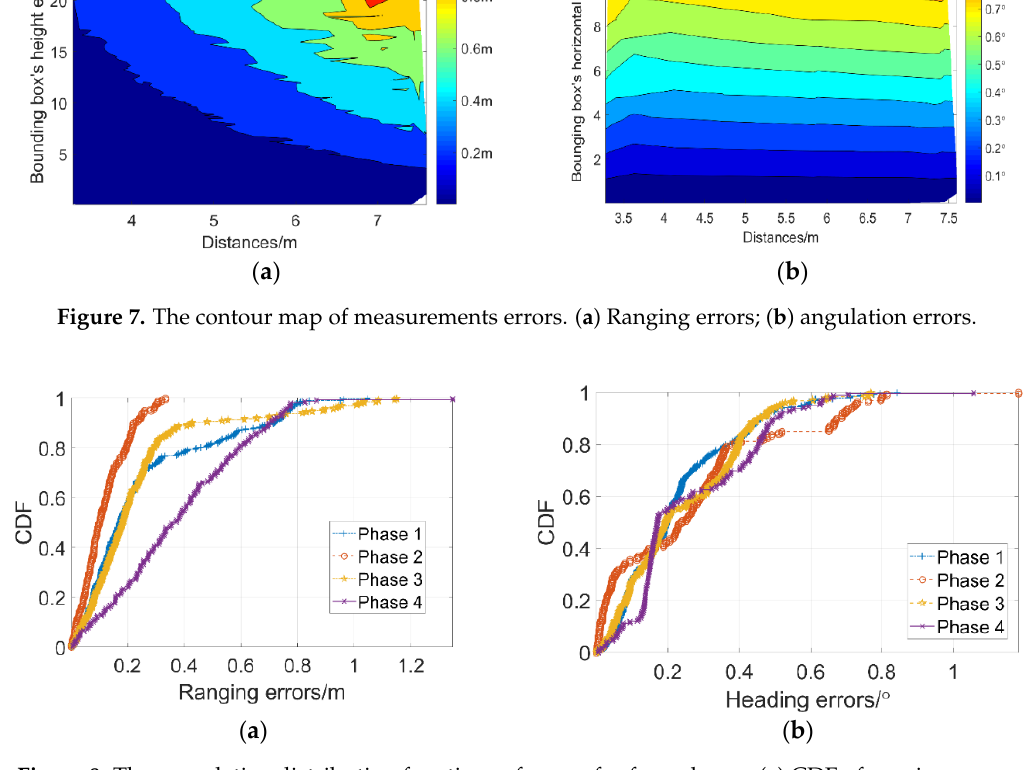
Figure 8. The cumulative distribution functions of errors for four phases. ( a ) CDF of ranging errors; ( b ) CDF of angulation errors. Table 1. The estimated position error caused by ranging and heading error in four phases. Phases P1 P2 P3 P4 By